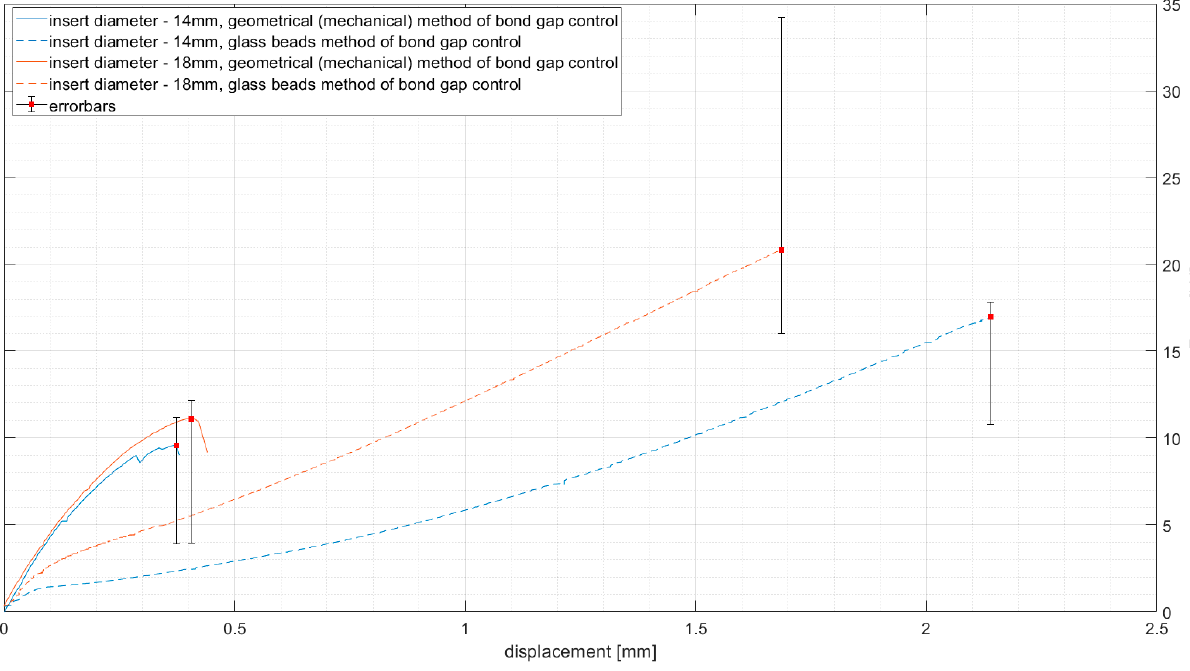
Figure 4. Force as a function of displacement for samples with EA 9466 adhesive.